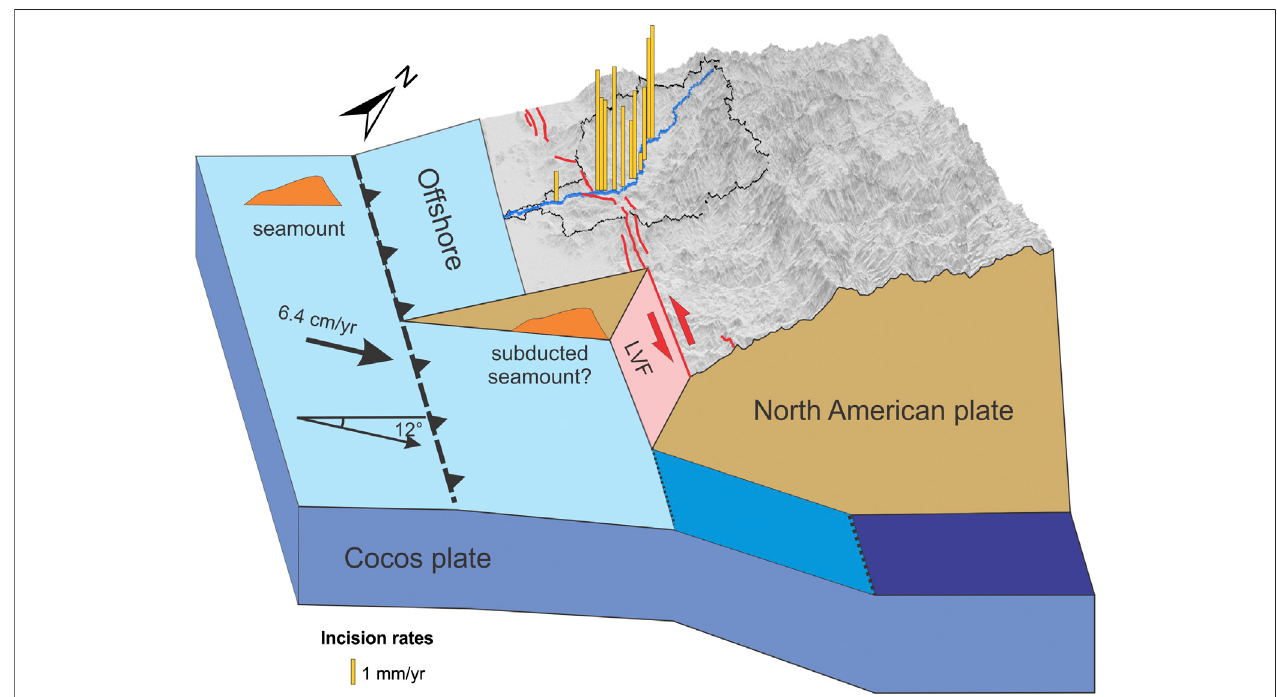
FIGURE10| DiagrampresentingthelocationoftheTecpanRiverdrainagebasininaforearcoftheMexicansubductionzone;LVF – plate-boundarysubparallelleft- lateralstrike-slipLaVentaFaultproducedbyobliqueMexicansubduction(theangleofobliquity (cid:1) 12 ° );blackarrowshowstheconvergencerate(DeMetsetal.,2010);red arrows show the left-lateral strike-slip motion along the forearc sliver. Note the correlation between LVF, bend in the geometry of the subducting slab, seamount subduction, and the apparent increment in the incision rates.